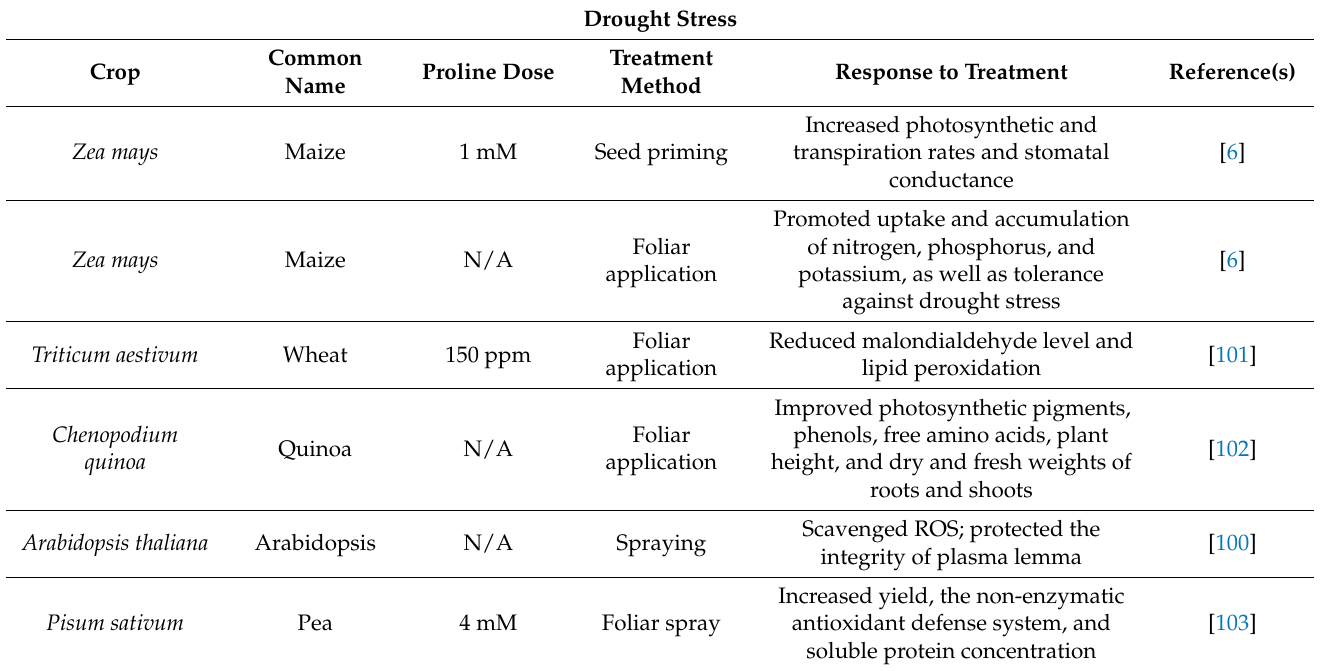
Table 11. Physiological responses of various crops to proline treatment against drought stress. Drought